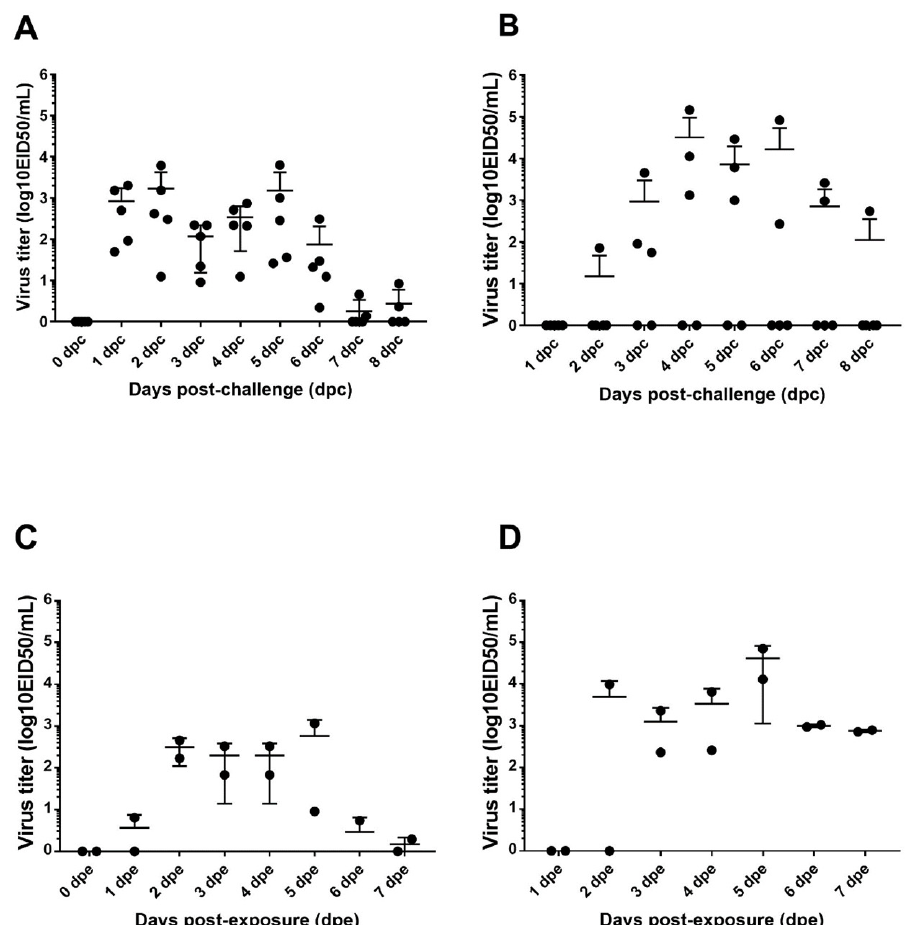
Figure 1. Viral titers from oral ( A , C ) and cloacal ( B , D ) swabs from day 0 to day 8 post challenge (dpc) or day 7 post exposure (dpe). Chickens were challenged with the A/duck/AL/2017 (H7N9) LPAIV virus at 3 weeks of age, and the swabs were collected daily. The contacts birds were introduced 24 h post challenge.